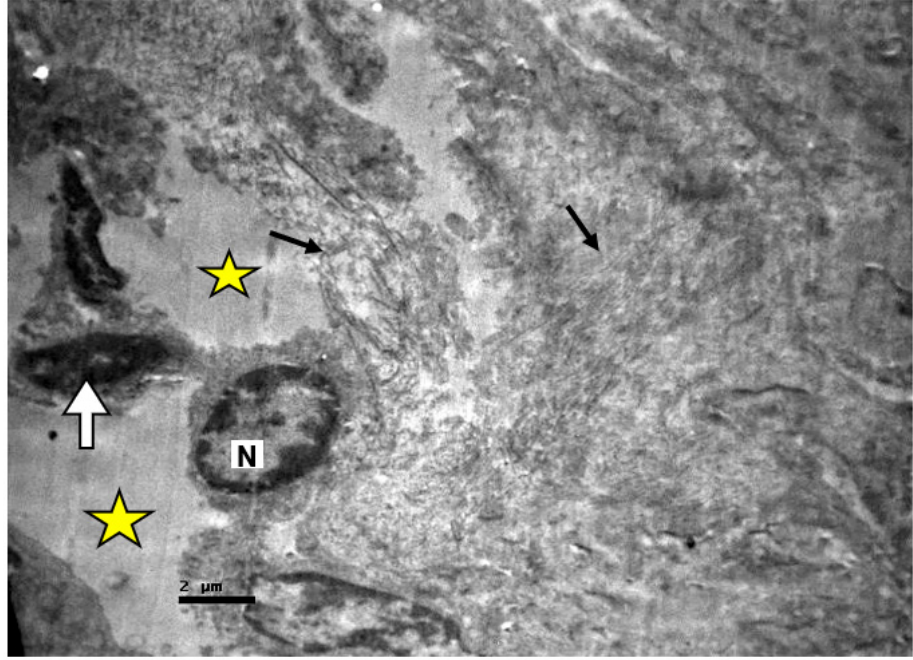
Figure 9. Connective tissue of resuscitated swine sample, that shows edema (yellow stars), activated fibroblasts (N), apoptotic cell (white arrow) and increased collagen fibers (black arrows).